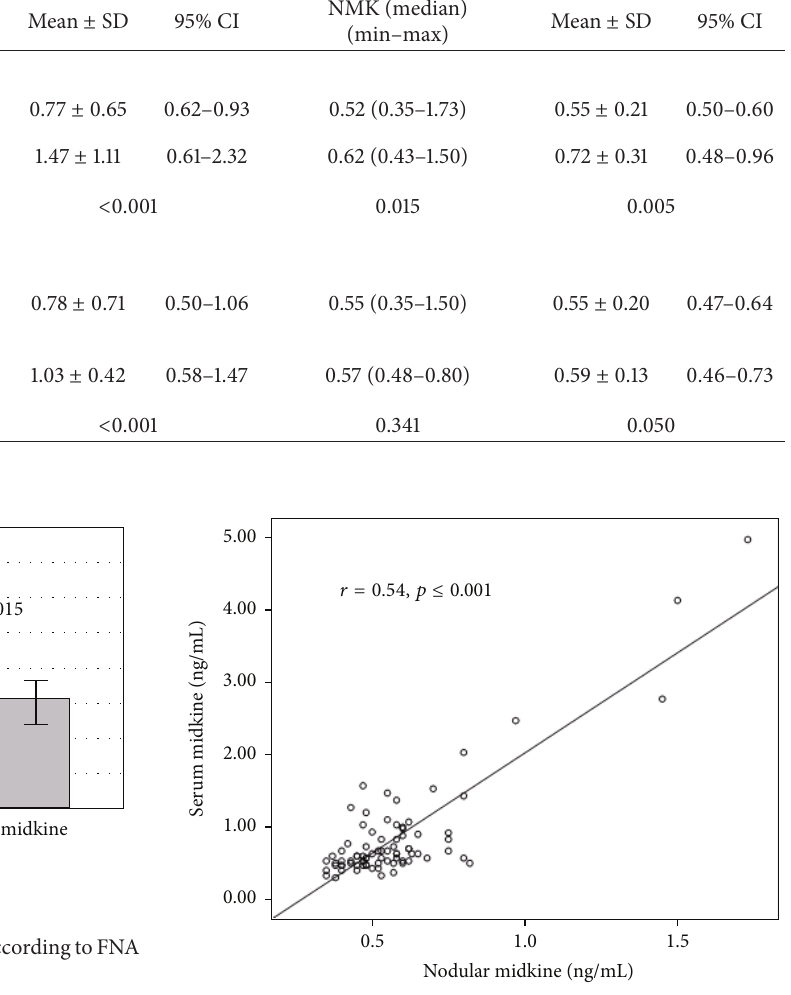
Figure 2: Correlation between serum and nodular midkine